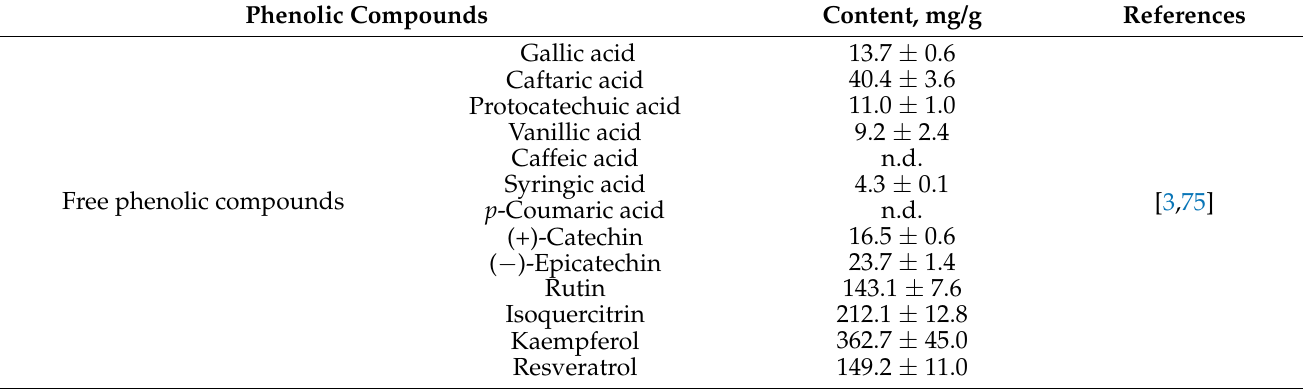
Table 2. Main phenolic compounds occurring in grape skin ( Vitis vinifera L.). Phenolic